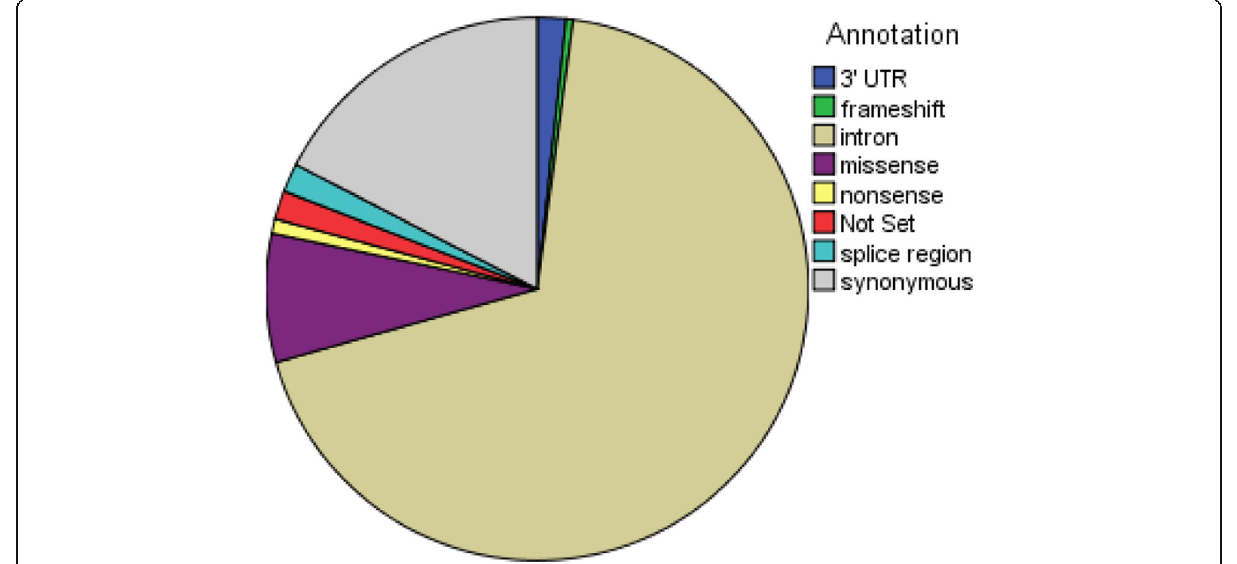
Fig. 1 The contribution of different MYH7 gene changes is indicated in the chart